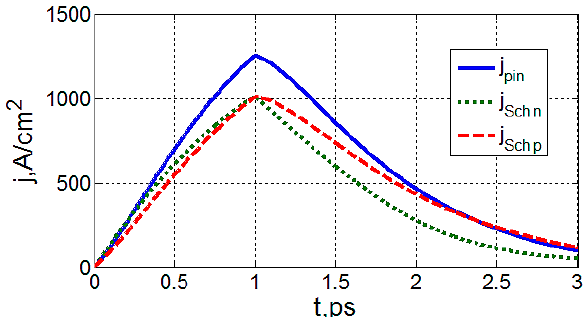
Figure 8. The time dependences of the photocurrent density modulus calculated at the optical pulse duration of 1 ps for the GaAs p-i-n structure ( pin j ) and Schottky-barrier photodiodes with n (j ) and p (j ) near-contact regions.